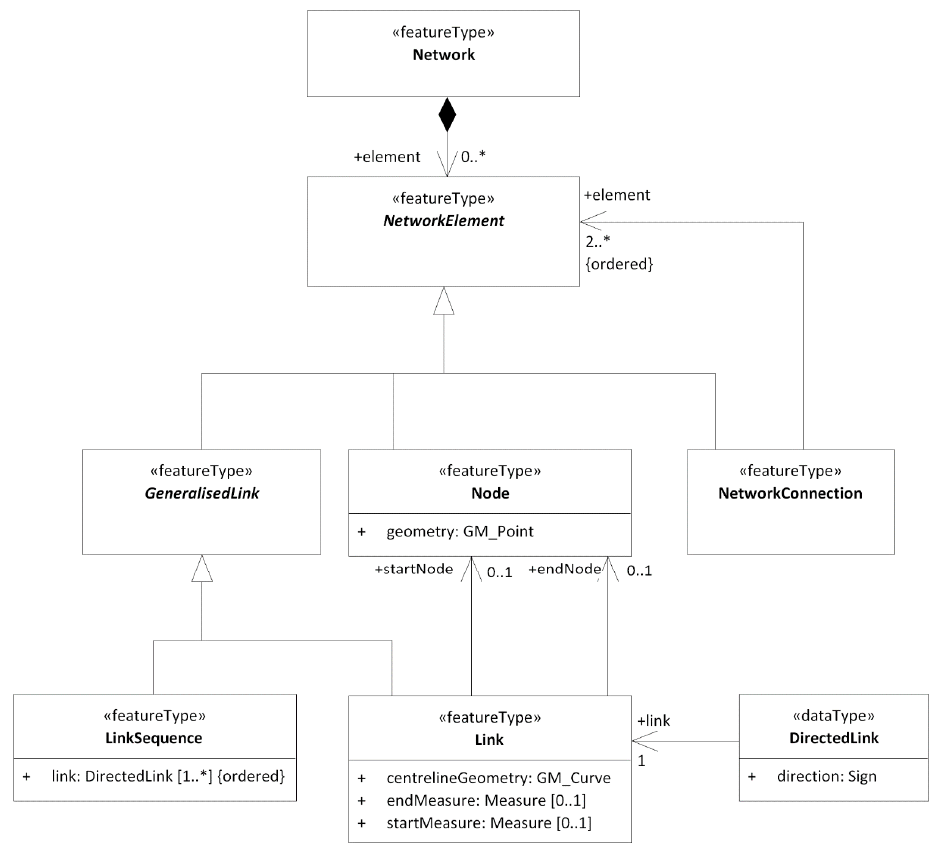
Figure 6. The Network Model in the prototype.